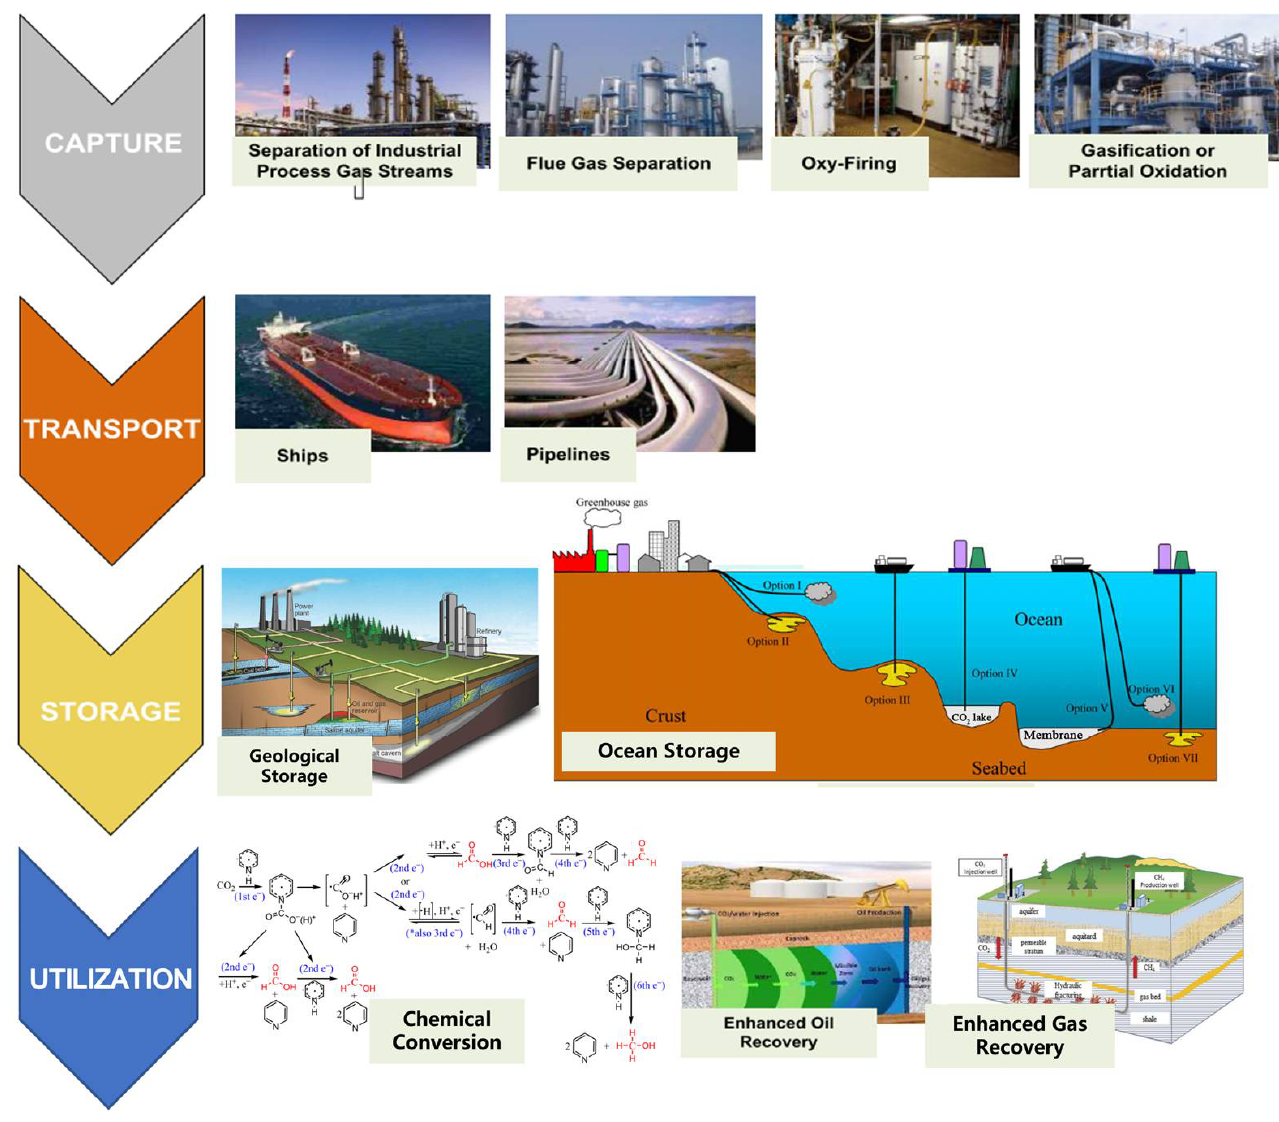
Figure 1. CCUS technology [1–5].